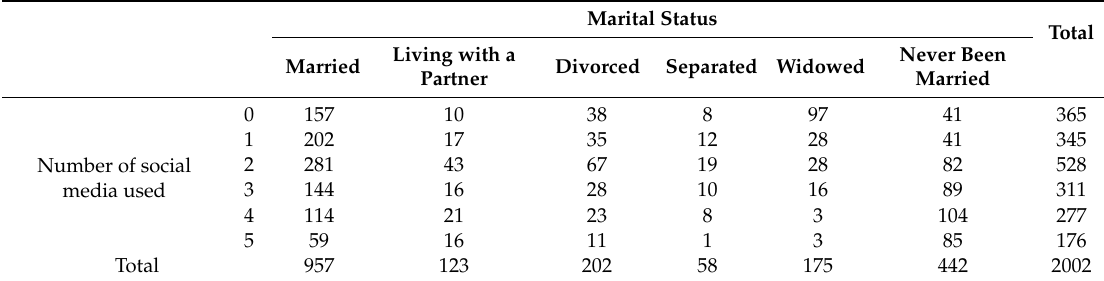
Table 3. Number of social media used by marital status.